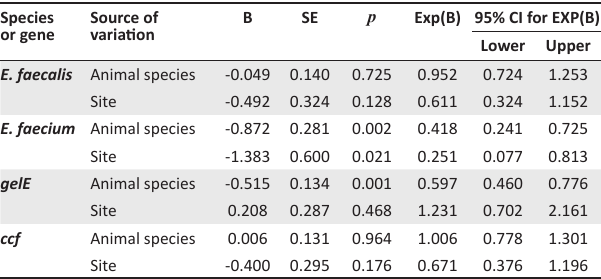
Site, site of swab collection; B, parameter estimates (log-odds) known as coefficient for the constant in the null model; SE, standard error around the parameter estimates; p = probability indicating level of significance; Exp(B), exponential of B (also called ‘odds ratio’) for the independent variable Xi; 95 % CI, 95 % confidence interval.